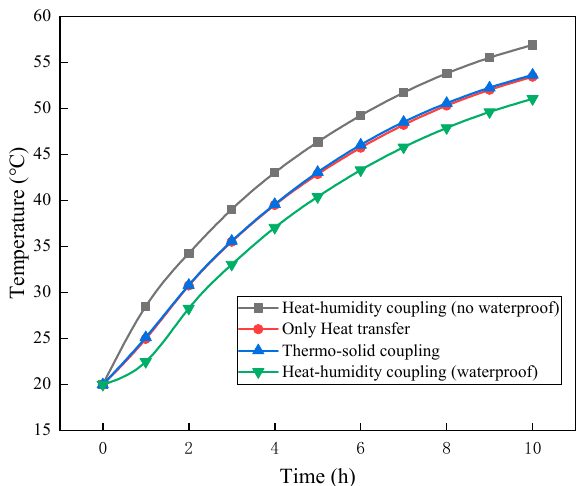
Figure 10. Indoor temperature curve under different coupling effects.